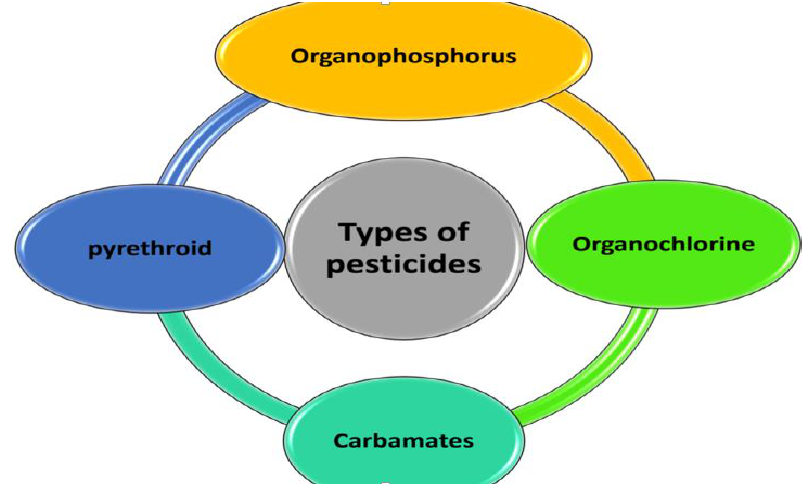
Figure 1. Types of pesticides based on chemical composition.